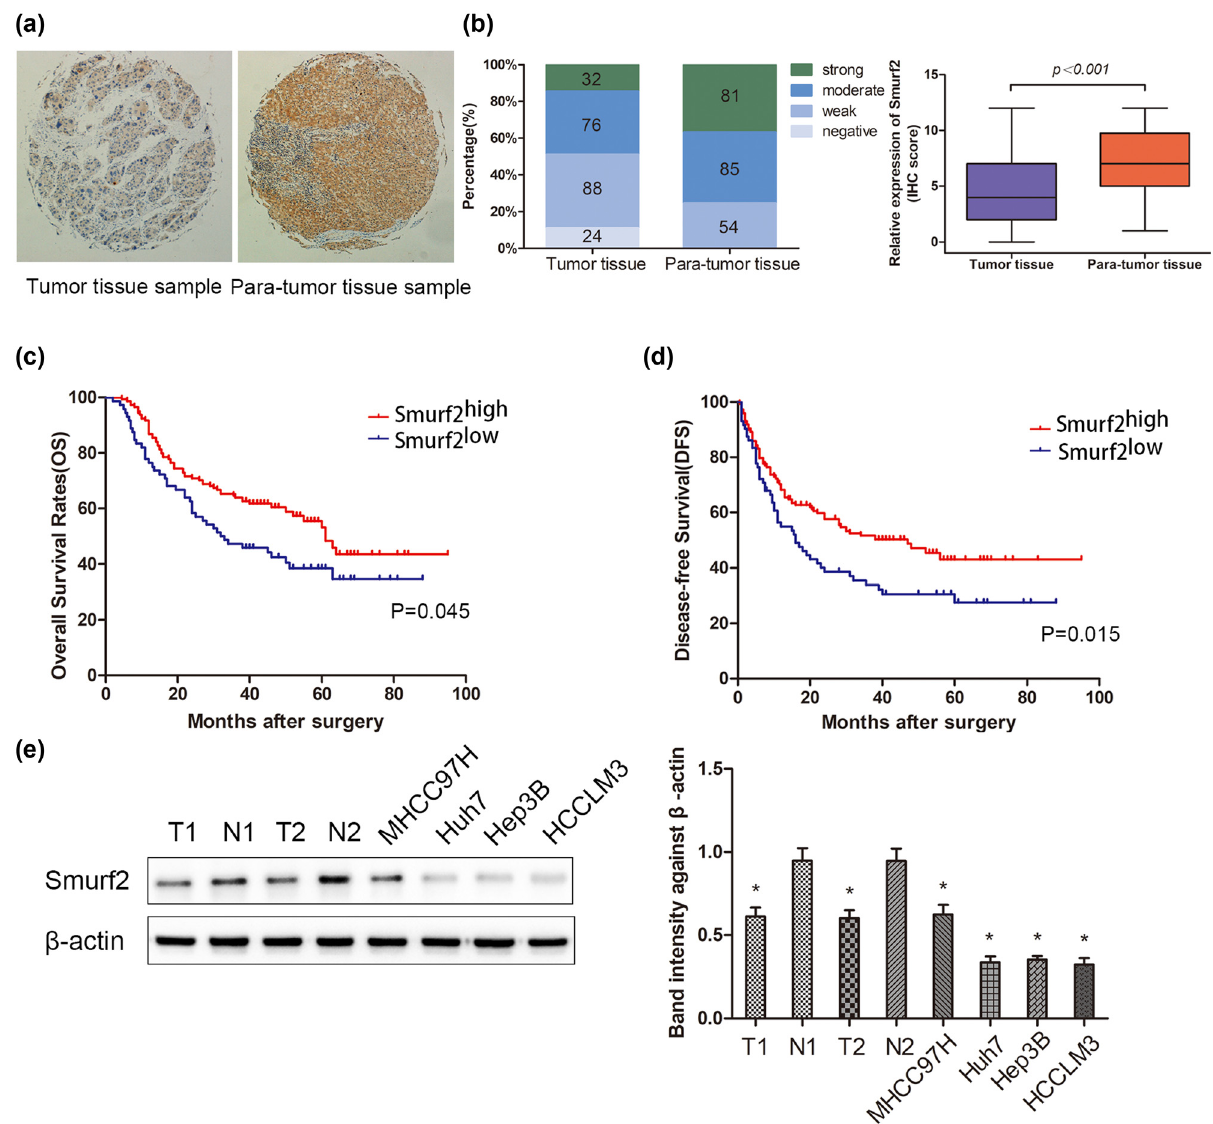
Figure 1: Smurf2 expression in HCC tissues and adjacent non - tumor tissues. ( a ) Representative immunohistochemical staining of smurf2 in tumor tissue and para - tumor tissue. Magni fi cation, × 200. ( b ) IHC score in HCC tissue and para - tumor tissue ( n = 220; P < 0.001 ) . ( c and d ) OS curve and DFS curve for HCC patients with high vs low expression of Smurf2 IHC score generated with Kaplan – Meier methods. ( e ) The immunoblotting of Smurf2 protein levels in HCC tissues ( T ) , adjacent non - tumor liver tissues ( N ) , and human HCC cell lines. * P <